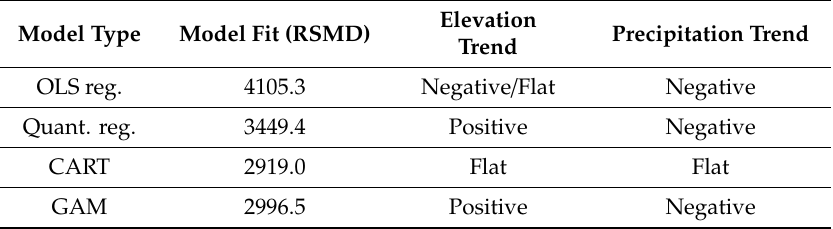
Figure 3. The fit of four different models ( a – d ) predicting tree cover bias (i.e., the difference between reference and Global Forest Change product (GFC) estimates), showing the conditional partial term for elevation. Reference points are in gray, and the blue line shows the partial term prediction. The y-axis is the estimated bias residuals remaining after fitting the other predictor (precipitation). Table 2. Model fit for prediction of bias along precipitation and elevation gradients. Model fit was assessed using root-squared mean deviance (RSMD) between sample and model-predicted bias, and using model trend direction for the conditional partial terms (elevation and precipitation). Models included linear regression (OLS reg.), quantitative median regression (quant. reg.), a CART decision tree (CART), and a general additive model